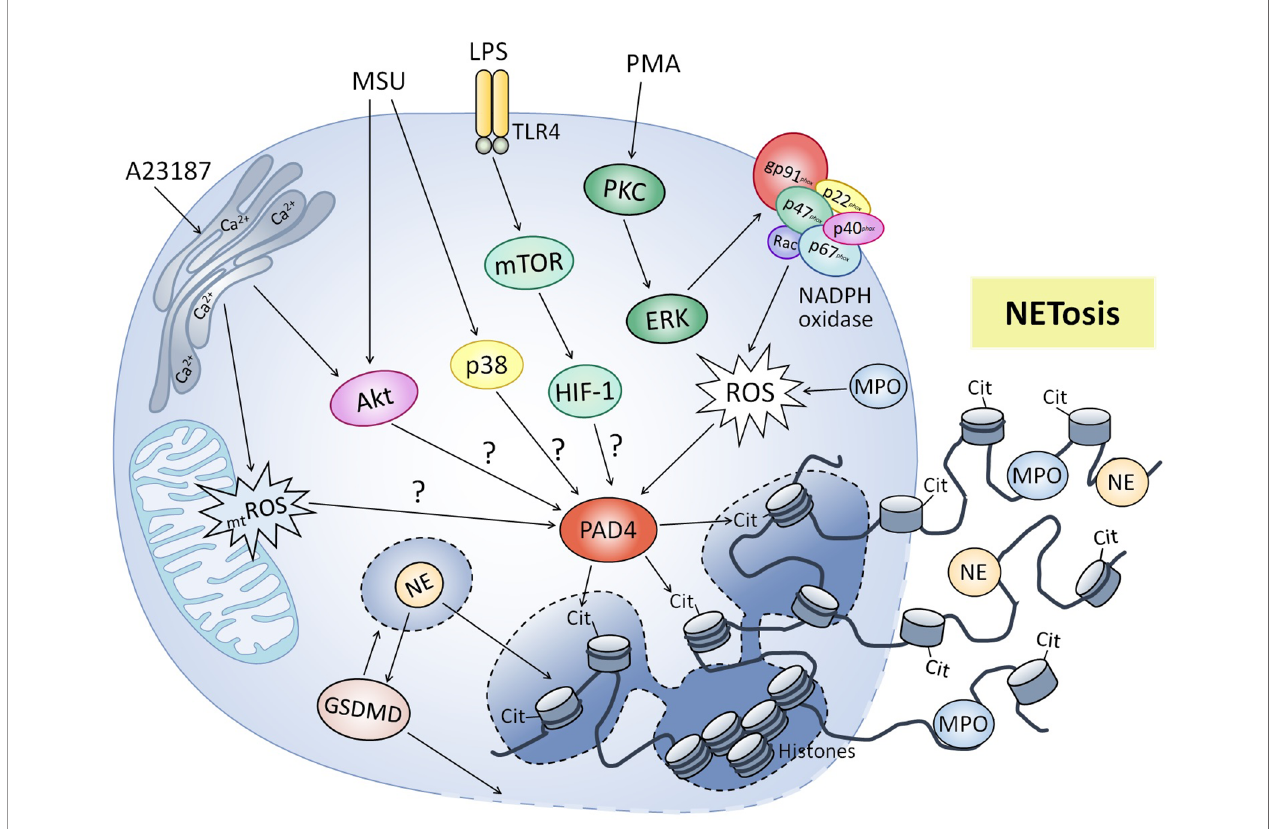
FIGURE 1 | Molecular mechanisms regulating neutrophil extracellular traps formation. Classic NETosis induced by phorbol 12-myristate 13-acetate (PMA) involved activation of NADPH oxidase via PKC, production of reactive oxygen species (ROS) and activation of peptidyl arginine deiminase 4 (PAD4), which results in hypercitrullination (cit) of histones and chromatin decondensation. Lipopolysaccharide (LPS) induces NET formation by mTOR/HIF-1 activation, although molecular mechanisms have not been elucidated (?). Other stimuli like calcium ionophore A23187 and monosodium urate (MSU) crystals also trigger NET formation independent of NADPH oxidase, involving signaling pathways like PI3K/Akt and p38 MAPK. Mitochondrial ROS ( mt ROS) production has been also involved in NADPH-independent NET release. Myeloperoxidase (MPO) participates in NETosis by generating oxidative compounds necessary for the release of neutrophilic elastase (NE). NE also helps chromatin decondensation and activates gasdermin D (GSDMD), which forms pores in the granular and plasma membrane facilitating the release of